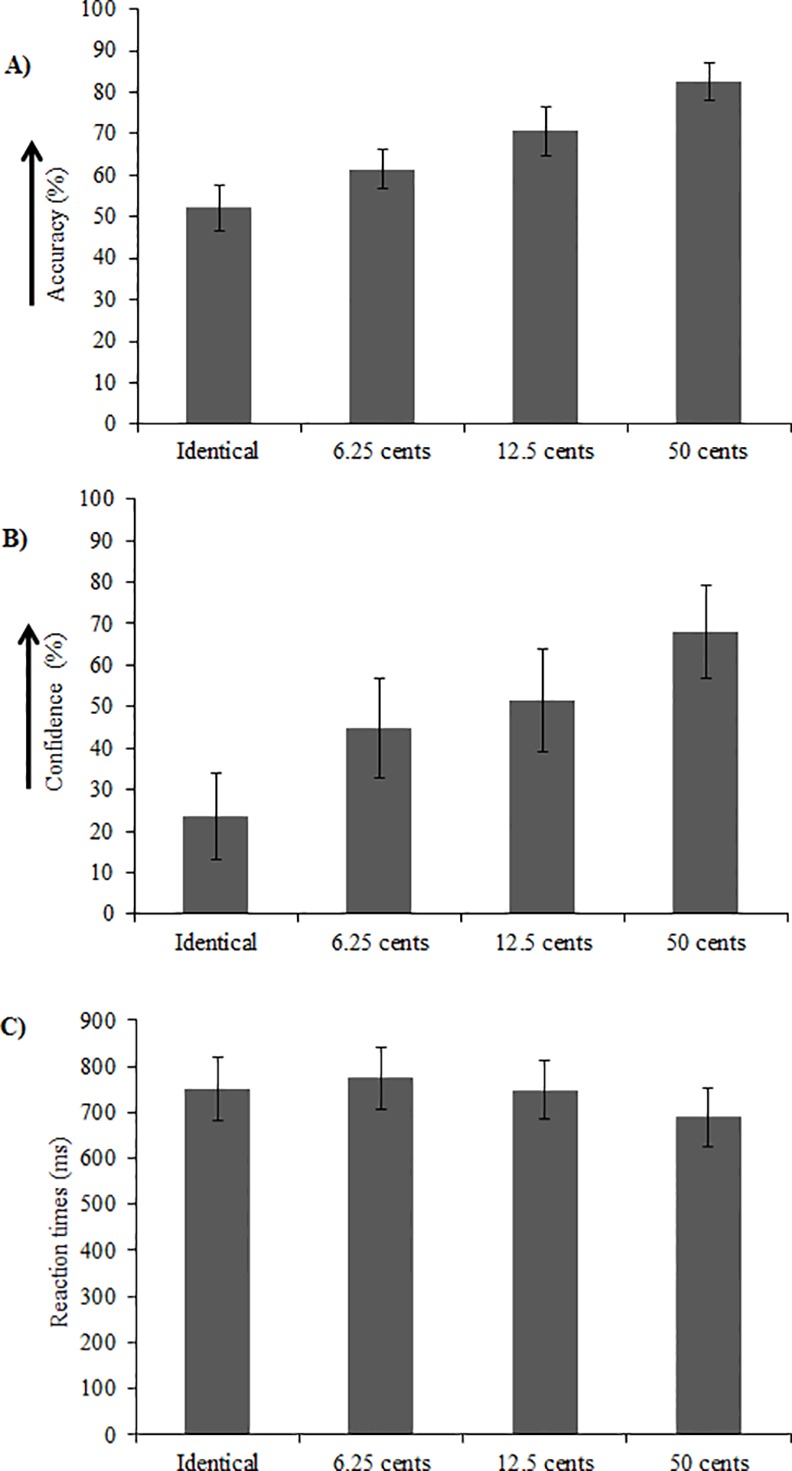
Behavioral results for the non-melodic task.Participants’ (A) accuracy (% correct), (B) confidence (% sure) and (C) reaction time (ms) for the non-melodic task. Results are presented as a function of experimental condition (i.e. Identical, 6.25, 12.50 and 50 cents). For the Identical condition in panel (A), accuracy reflects the proportion of “higher in pitch” responses, and thus accuracy of 50% is indicative of non-biased responses.